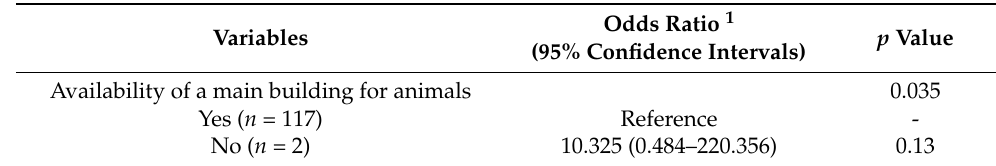
Table 5. Results of multivariable analysis for the presence of Giardia in faecal samples from 119 goat herds.